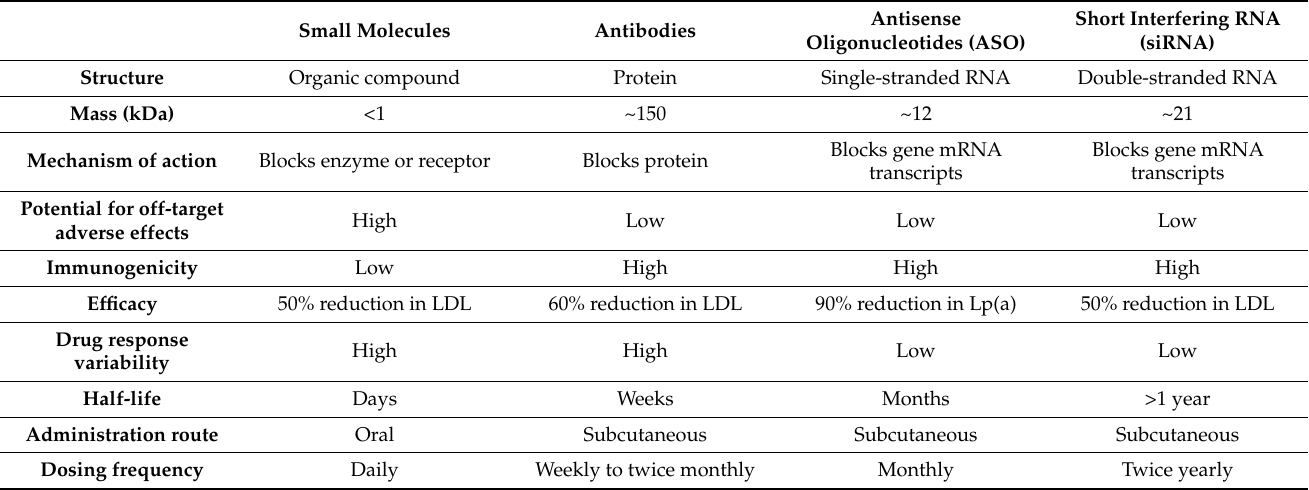
Table 1. Characteristics of Different Anti-hypercholesterolemia